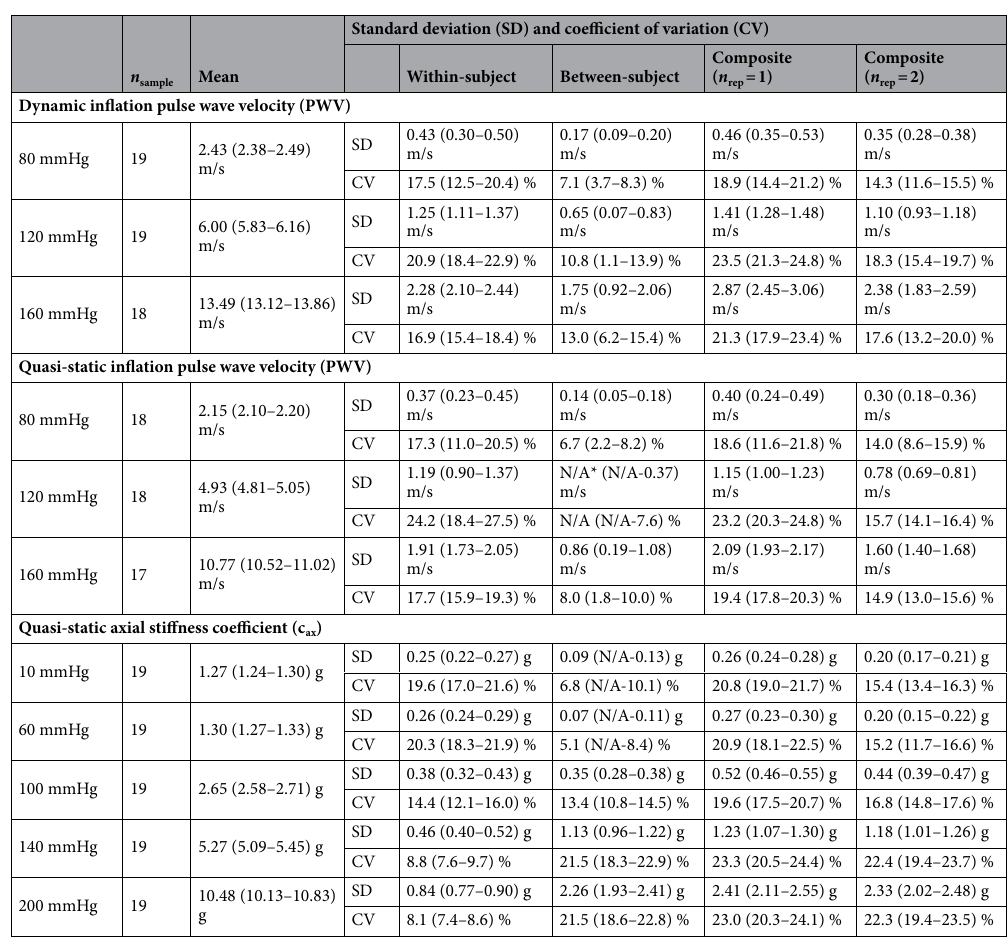
Table 1. Repeatability statistics. n sample : number of included samples. Only samples which were measured in duplicate are included in this analysis (hence 2 n sample : number of included measurements). Values between parentheses indicate the 25–75% confidence interval, obtained using (nonparametric) percentile bootstrapping. Within-subject and between-subject SDs based on analysis described by Rodbard 67 . N/A not applicable; imaginary number arising from a negative estimated between-subject variance caused by sampling error. Composite SDs ( s ) represent the expected ‘between-sample variation’ for an unknown sample of n rep replicates, and were calculated using s = (cid:31) s 2 b + s 2 w / n rep , with s b and s w the between- and within-subject SD, respectively. This equation can also be used to estimate expected SDs for any n rep , which may be useful for power calculations for future studies. *For quasi-static PWV at 120 mmHg, s 2 b = − 0.11 m 2 / s 2